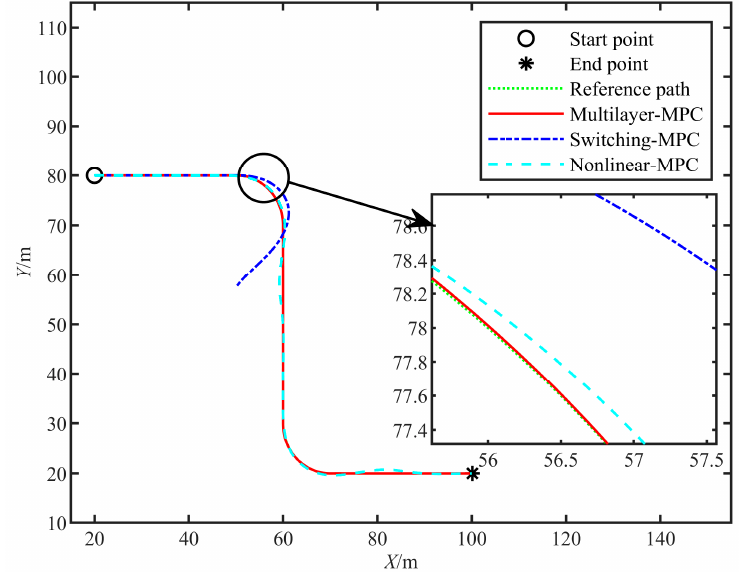
Figure 4. The trajectory of the comparison between controllers. Table 2. Maximum errors.